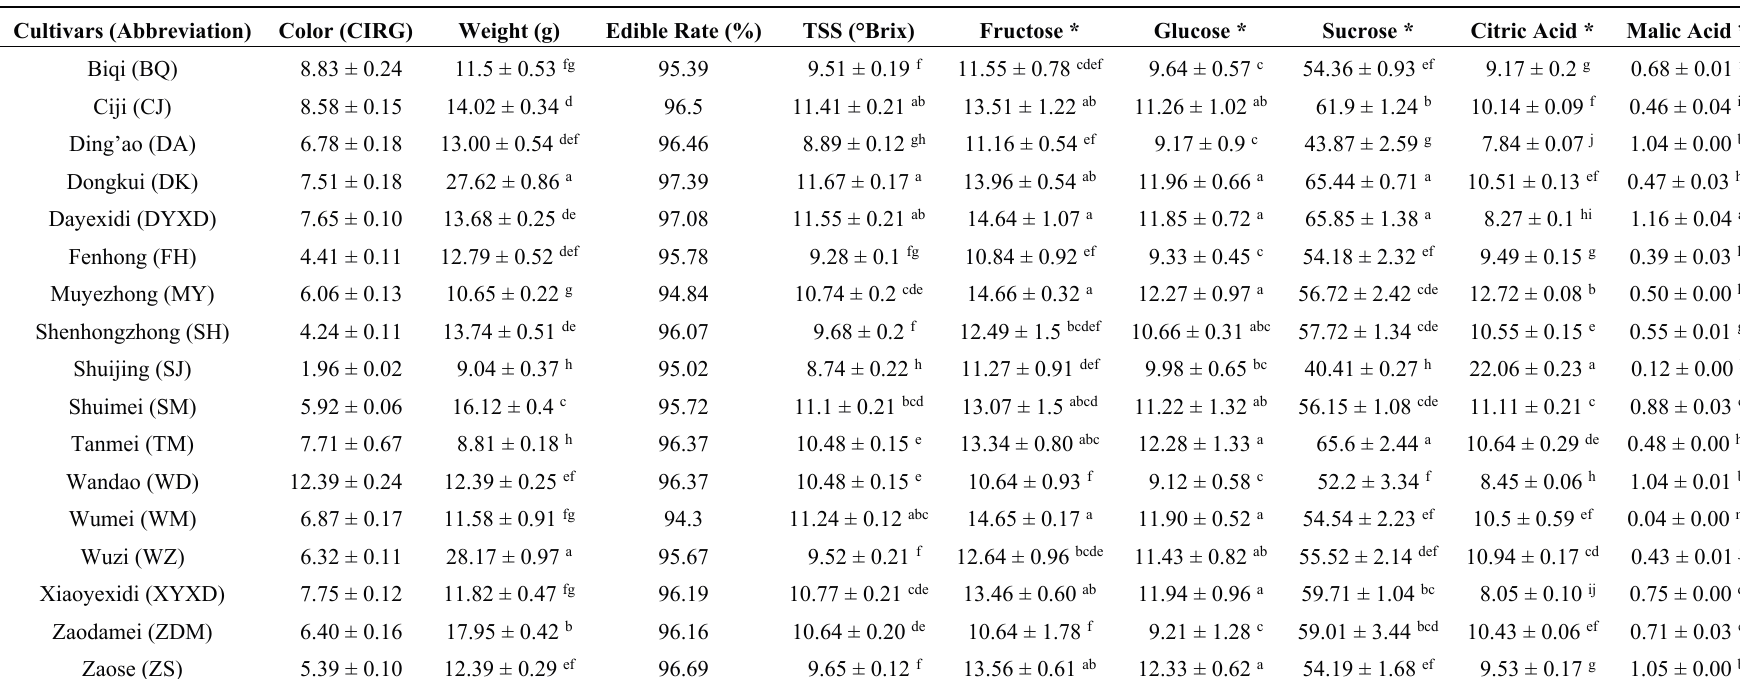
Table 1. Appearance and taste qualities of Chinese bayberry fruits of 17 cultivars. TSS, total soluble solids. Cultivars